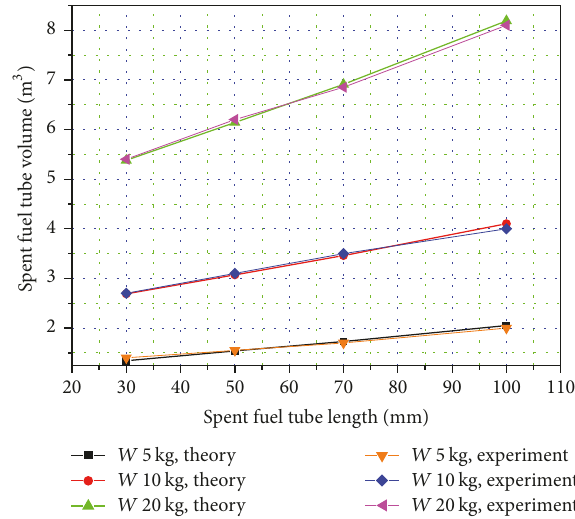
Figure 13: Rod-cut volume as a function of rod-cut length and